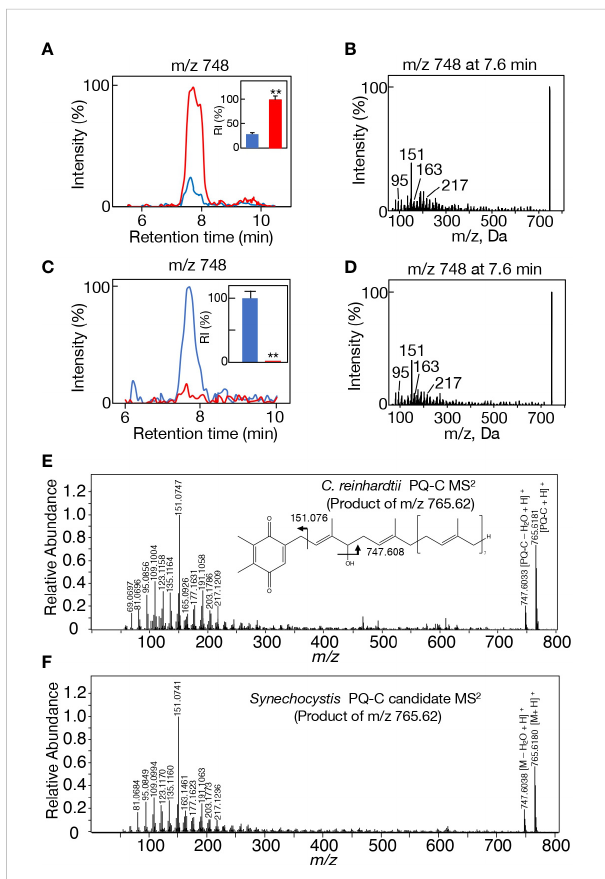
FIGURE 5 Candidate alcohol that Slr2103 acts in lipid X synthesis. (A) MS chromatogram of m/z 748 on LC-MS analysis of total lipids in WT (blue) or D slr2103 (red). The signal intensity of m/z 748 relative to the total lipid fraction in D slr2103 was adjusted to 100%. Inset, the estimated relative signal intensity of m/z 748. (B) MS 2 spectrum of m/z 748 in D slr2103 . (C) MS chromatogram of m/z 748 on LC-MS analysis of total lipids in EV (blue) or OE (red) in Synechococcus . The signal intensity of m/z 748 relative to the total lipid fraction in EV was adjusted to 100%. Inset, the estimated relative signal intensities of m/z 748. (D) MS 2 spectrum of m/z 748 in EV. (E) High-resolution MS 2 spectrum of H + -adducted PQ-C in C reinhardtii . The structure of PQ-C with the hydroxy group at the fi rst isoprene unit is tentatively shown. (F) High-resolution MS 2 spectrum of H + - adducted Y 765 in Synechocystis . The values shown are averages ± SD for three experiments. The signi fi cance of differences was evaluated by means of Student ’ s t -test.